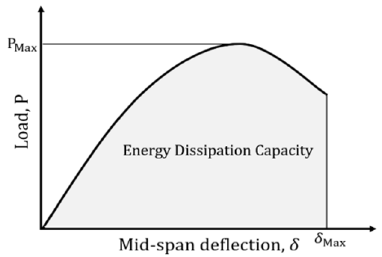
Figure 4. Energy dissipation capacity.